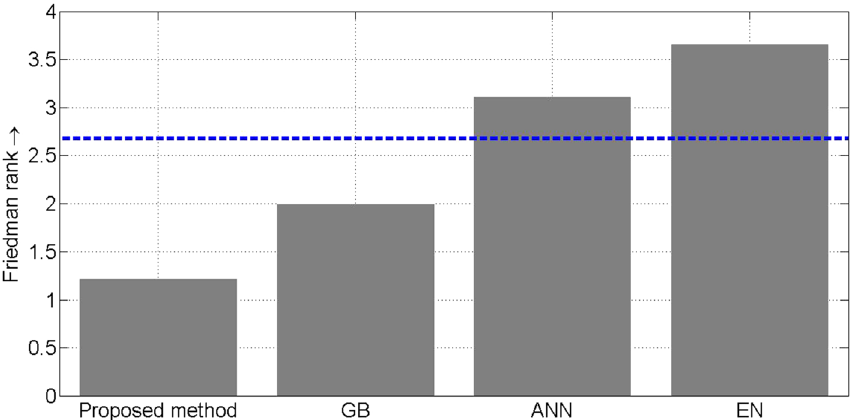
Figure 6. MAPE obtained by different competitive algorithms for different length of action sequence (test data).